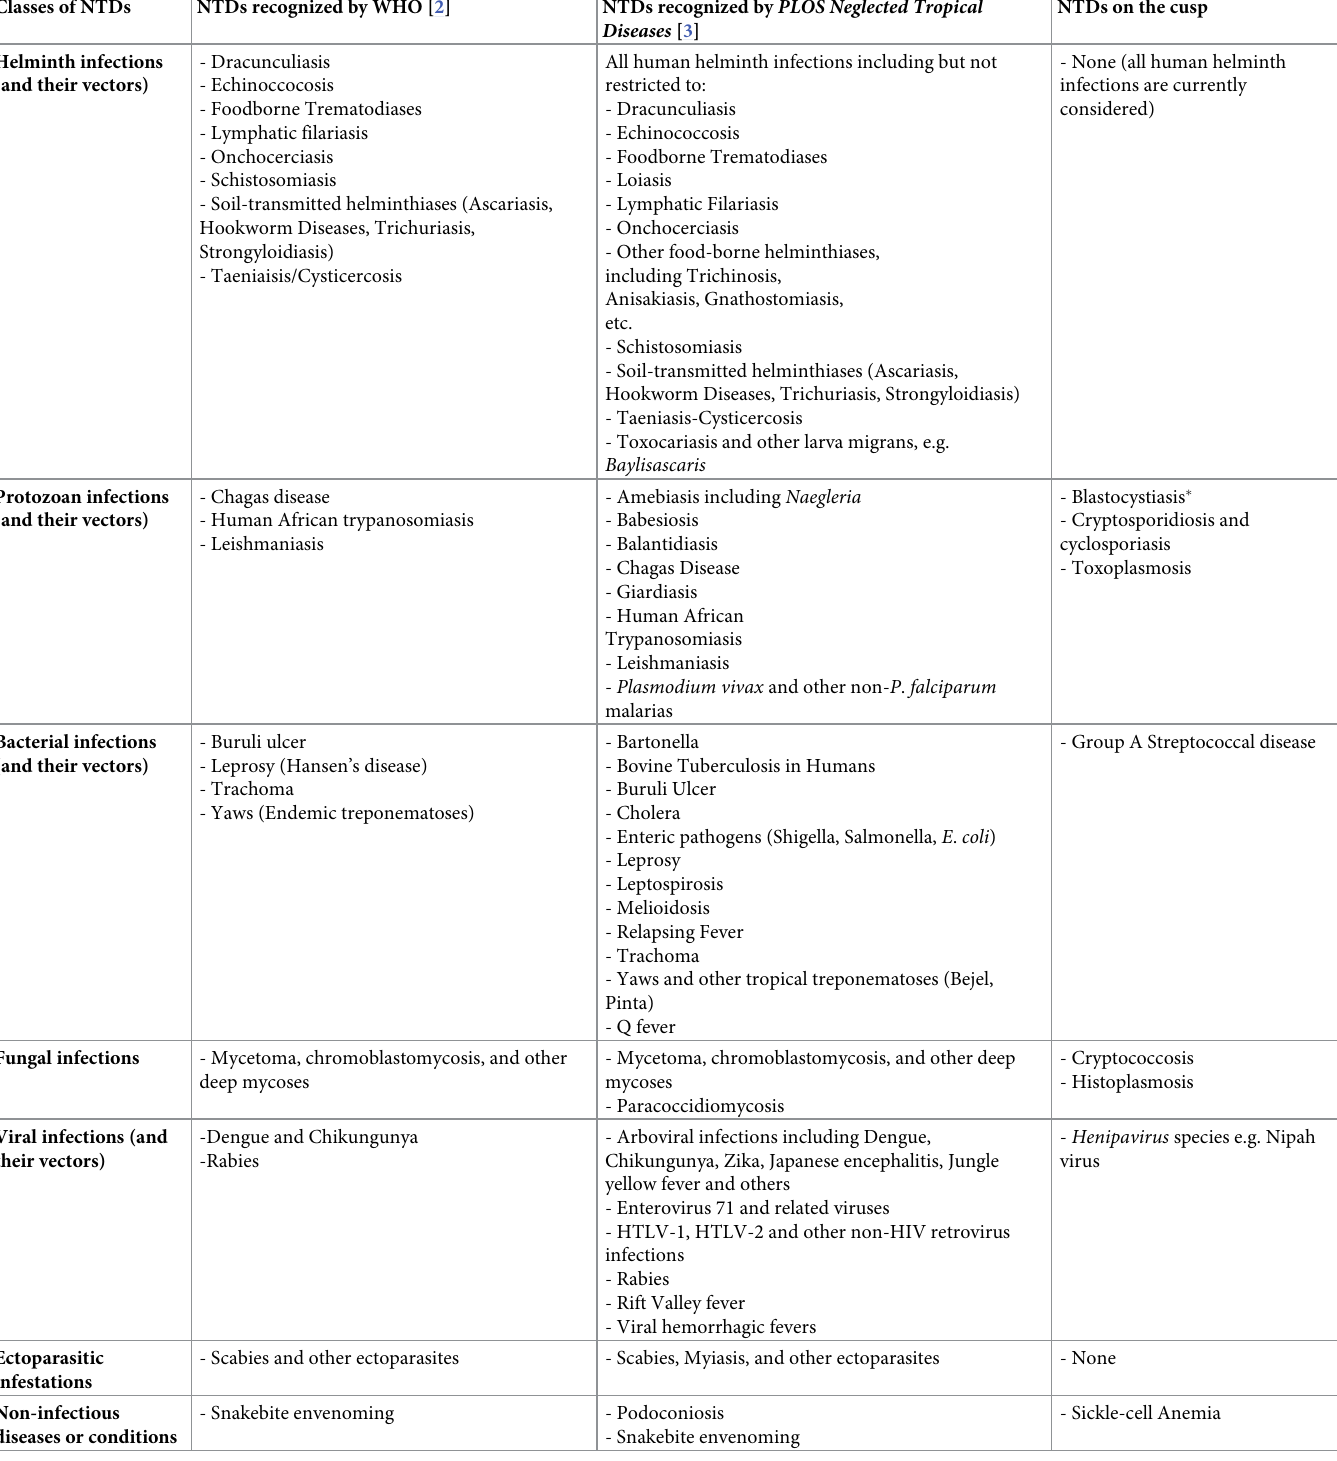
Table 1. Listing the world’s NTDs by WHO and PLOS Neglected Tropical Diseases. NTDs on the cusp refer to conditions that might be added downstream. Classes of